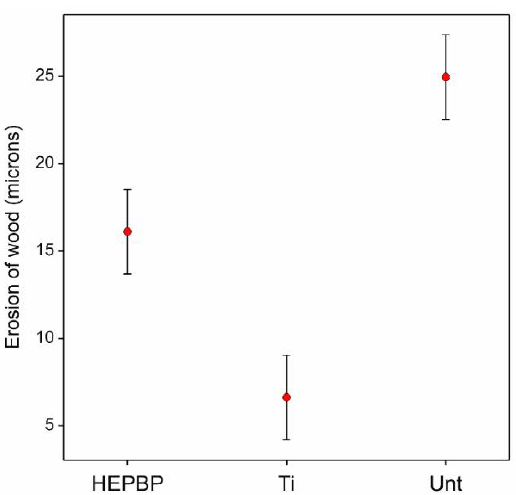
Figure 7. Erosion of treated and untreated yellow cedar panels after six months of natural weathering in Vancouver, Canada: (five panels per treatment including the untreated control).